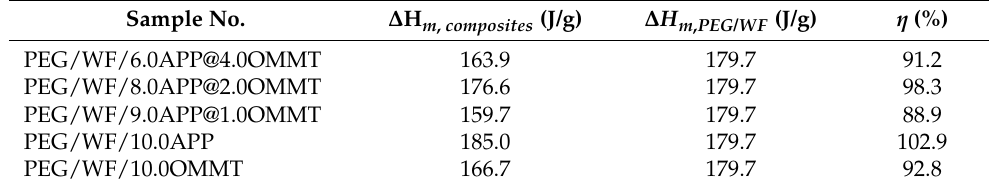
Table 3. Thermal energy storage characteristics of different composites in the present study. Sample No.